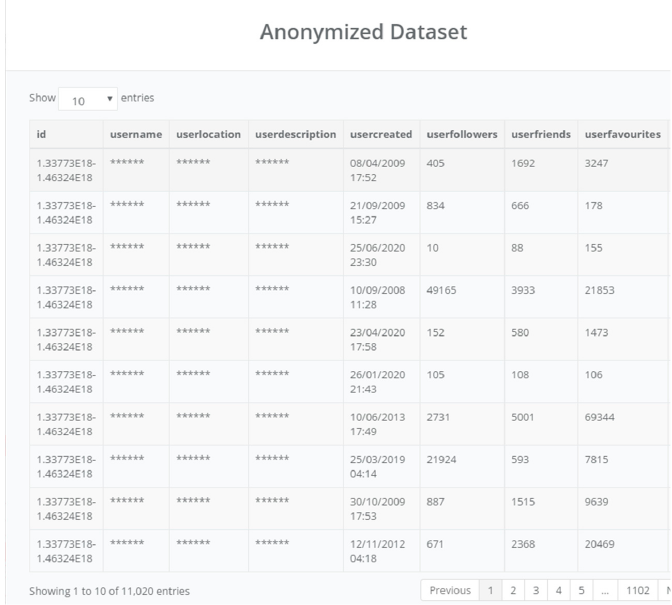
Figure 18. Anonymized Dataset.